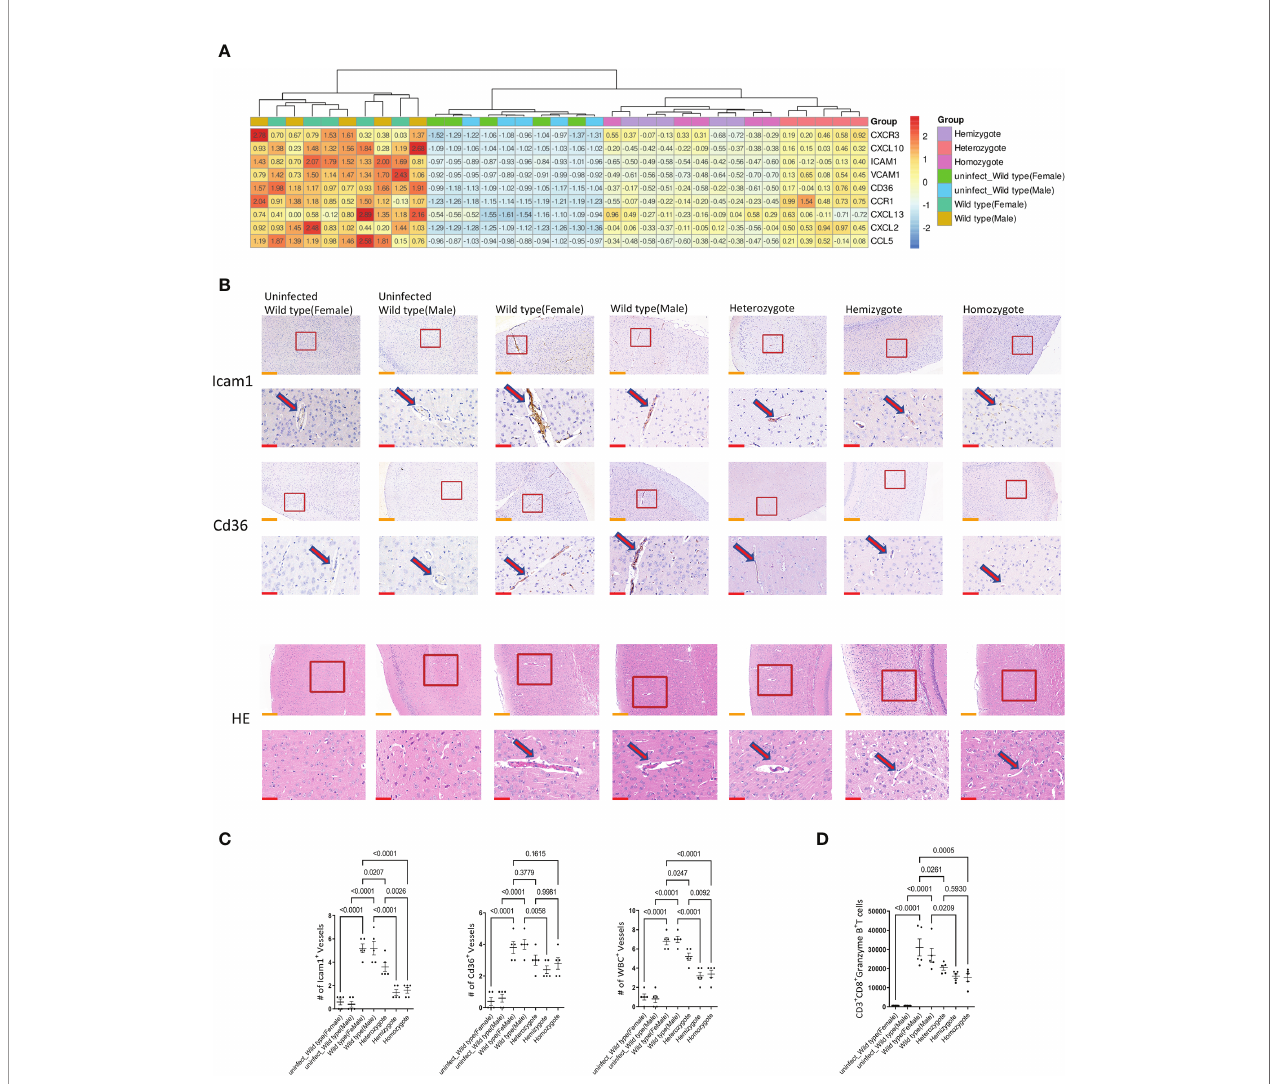
FIGURE 4 | G6pd-de fi cient mice reduced chemokines and adhesion molecules expression in brain compared with wild type mice in response to P.berghei infection. (A) Heatmap of relative chemokines and adhesion molecules expression in brain on day 7 post-infection. Expression levels were quanti fi ed by real-time quantitative PCR with b -actin as the internal reference and normalized. (B) Brain pathology of mice. Representative images of brain sections with the microvessels (arrows) from uninfected and P.berghei infected mice on day 7 post-infection. The contents present in the red box are indicative of the high magni fi cation observation of the display. Yellow scale bars, 200 m m; Red scale bars,50 m m. (C) The plot graphs show quanti fi cation of the data in (B) . Microvessels per microscopic fi eld were quanti fi ed in 20 fi elds per mouse and the values are presented in the corresponding plot graphs. (D) The cell number of CD8 + T cells (CD45 + CD3 + CD8 + Granzyme B + ) in brain were quanti fi ed. (n=5/each group, data are representative of three independent